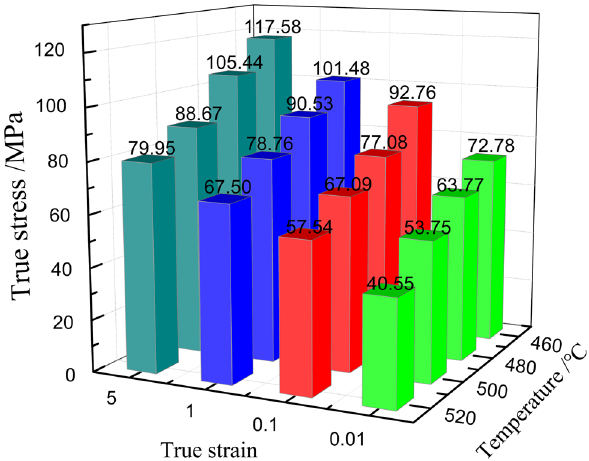
Figure 5: Peak stress under di ff erent deformation